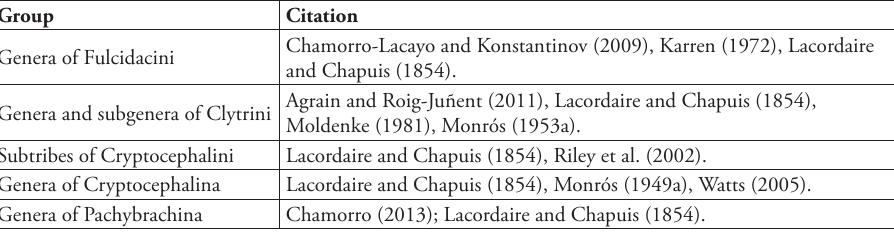
Table 1. Main sources of information used for the identification key.